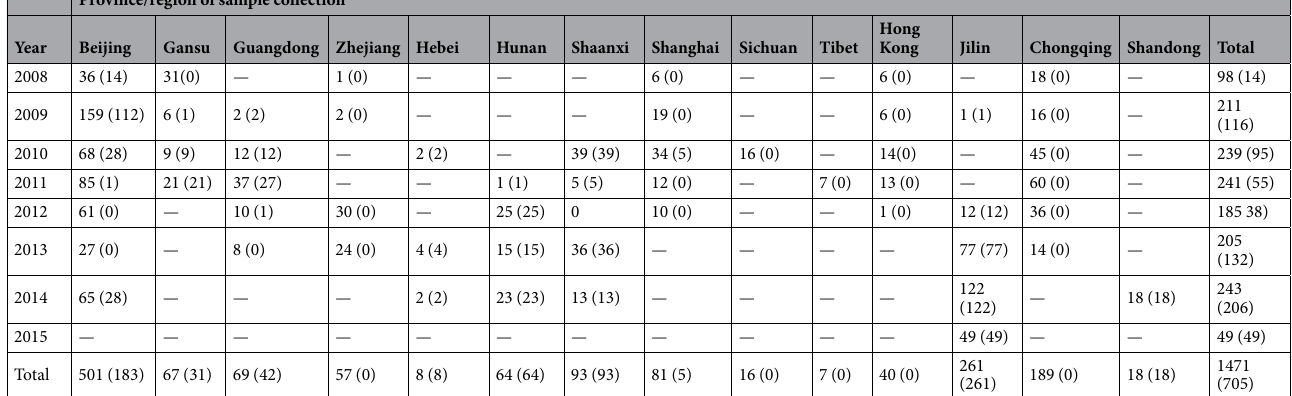
to 10% in older adults living in congregate settings 9 . Therefore, HRSV-associated lower respiratory tract infection is a big concern for public health. HRSV is a member of the Pneumovirinae subfamily in the Paramyxoviridae family. It consists of a non-segmented, single-strand negative RNA genome packaged in a lipid envelope. The genome of HRSV is about 15.2 kb in length and encodes 10 genes and 11 proteins: NS1, NS2, N, P, M, SH, G, F, M2-1, M2-2, and L 10 . The F protein and G protein are the major surface glycoproteins. Both of them can stimulate the production of neutral- izing antibodies. The sequence of the F protein is highly conserved, while that of the G protein is hypervariable. Due to the genetic diversity in the G gene, sequence encoding the second hypervariable region in the C-terminal (HVR2) of the G protein has been used for genotyping of HRSV. According to the genetic characteristic and reactivity with monoclonal antibodies, HRSV is classified into 2 subgroups, A (HRSVA) and B (HRSVB) 11 . To date, there are 15 genotypes of HRSVA (GA1-GA7, SAA1, CB-A, NA1-4 and ON1-2) 12–15 , and 24 genotypes of